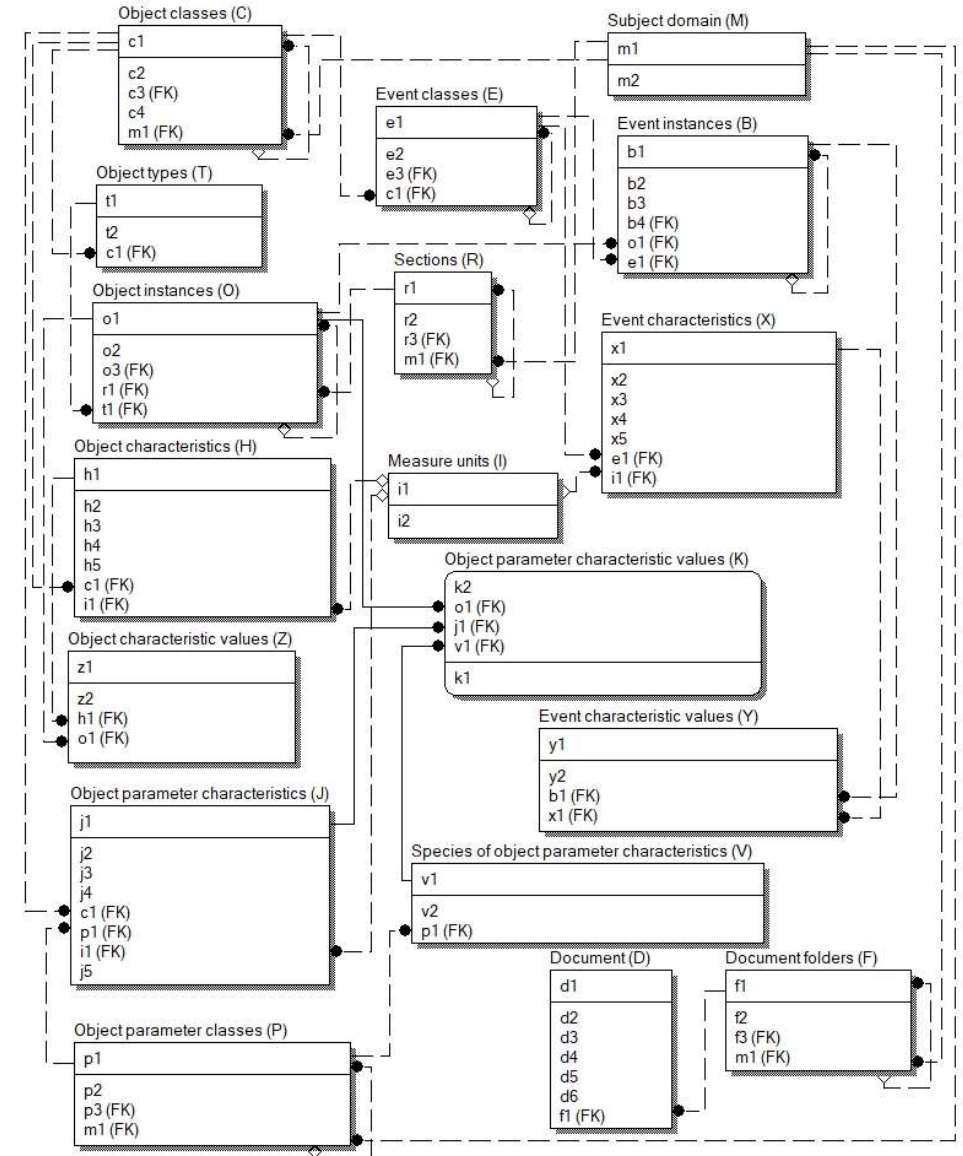
Figure 1. Diagram of the main basic relations R sh of the DB schema with